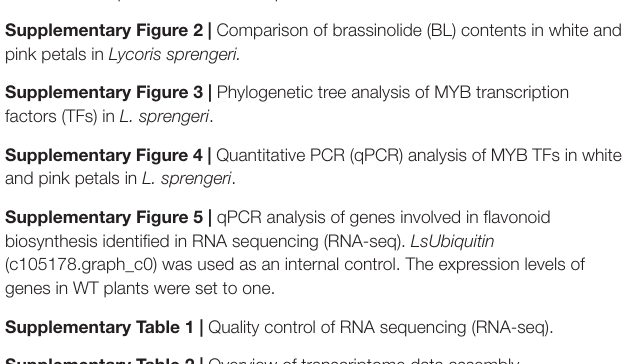
Supplementary Table 8 | Total SNPs in this study. Supplementary Table 9 | Simple sequence repeat (SSR) analysis in this study. Supplementary Table 10 | Primers used for quantitative PCR (qPCR) analysis in this study. Supplementary Table 11 | Comparison of the transcriptome analysis in recent studies. Supplementary Table 12 | All annotated unigene numbers from different databases. Supplementary Table 13 | pH measurements in white and pink